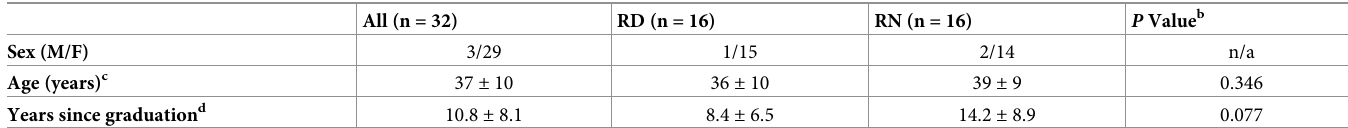
Table 2. Participant characteristics according to profession (RD, n = 16; RN, n = 16) a .